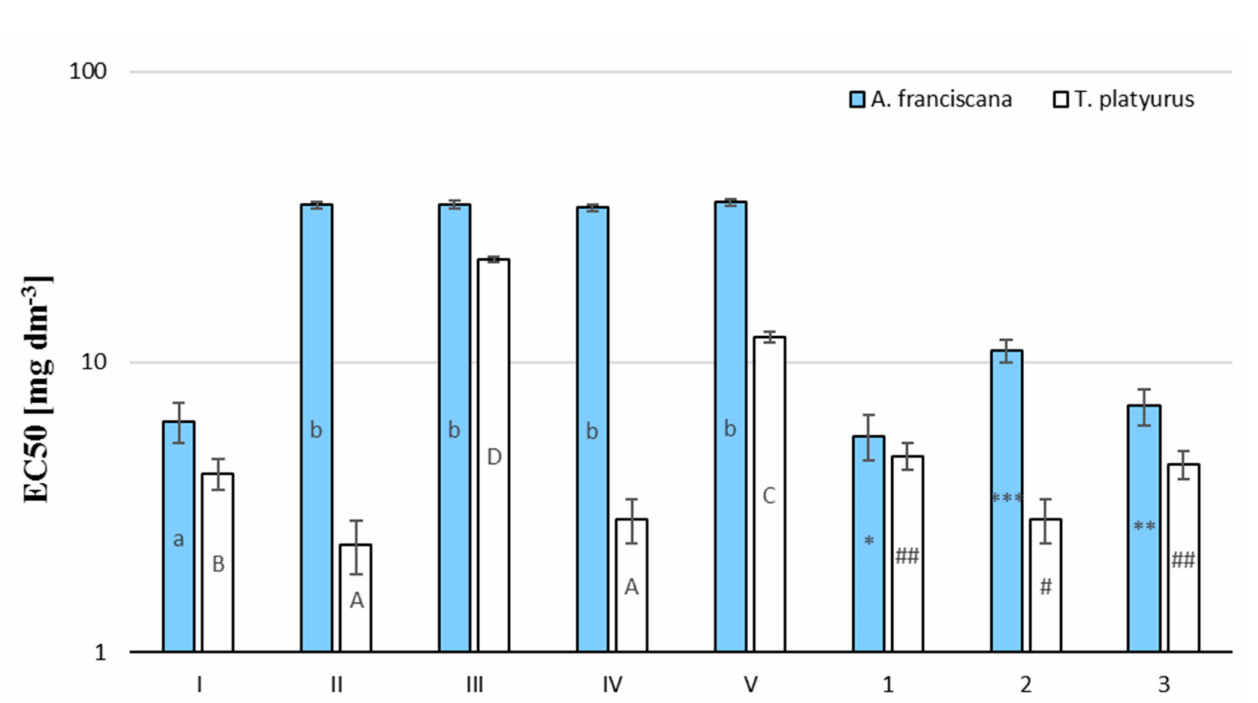
Figure 7. Mean 24 h EC 50 values of the investigated compounds and post-reaction mixtures for A. franciscana (blue) and T. platyurus (white). The mean value ± SD, n = 3 of the result was presented, statistical ( p < 0.01) differences between the results, assessed by Statistica 13.1 Student’s test, are indicated by different small letters for A. franciscana, capital letters for T. platyurus, number of *, **, *** for post-reaction mixtures tested on A. franciscana, number of # , ## for post-reaction mixtures tested on T. platyurus, difference at p <